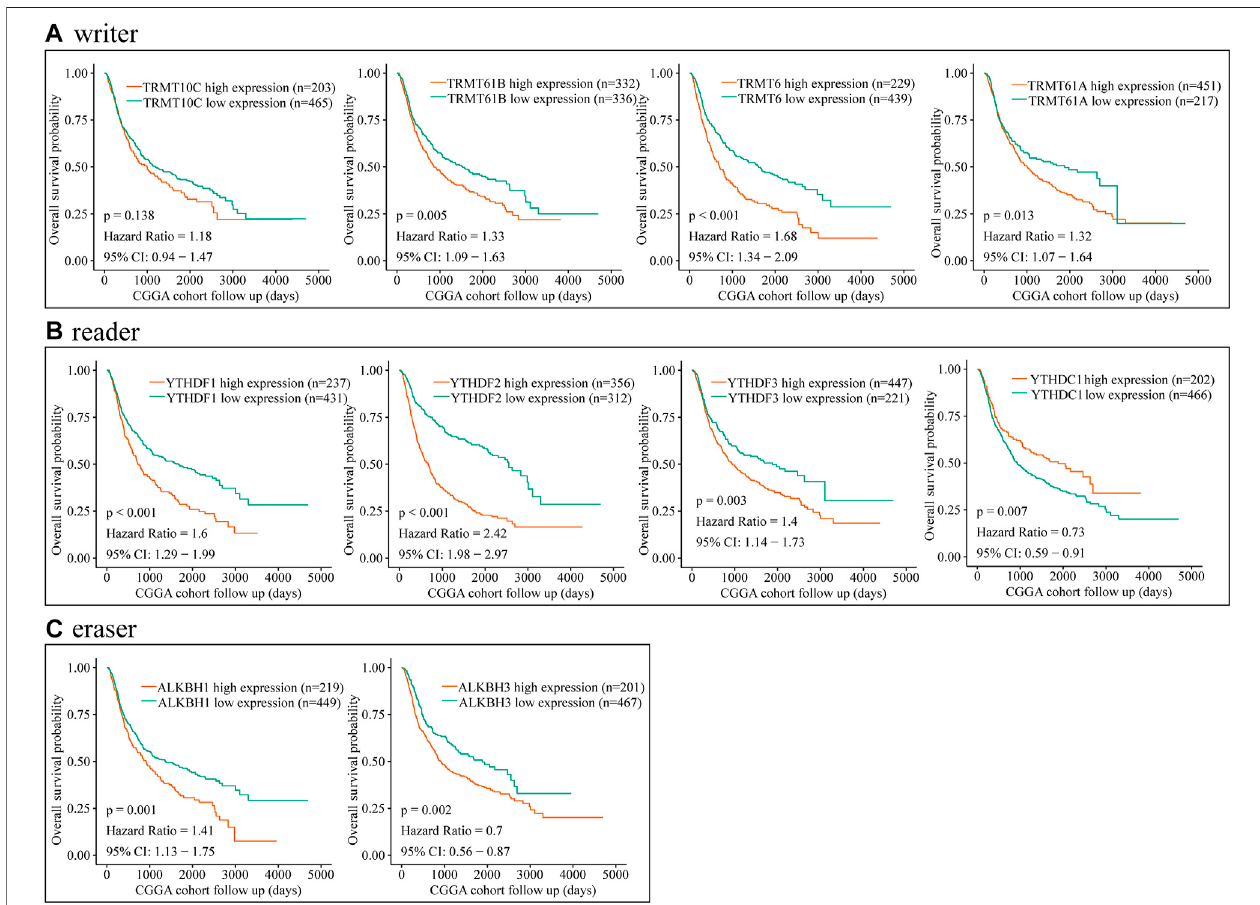
FIGURE 2 | Prognostic value of the m1A regulators in glioma according to CGGA database. (A – C) Kaplan – Meier analysis showing the correlation between m1A “ writers ” expression levels and the glioma patients overall survival rates according to CGGA database.